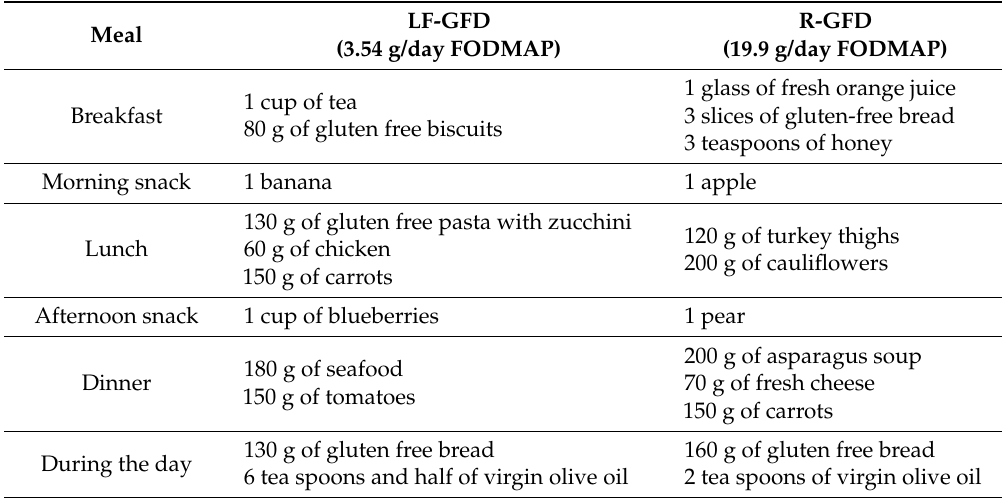
Table 1. Examples of the two different prescribed diets for a typical day 1